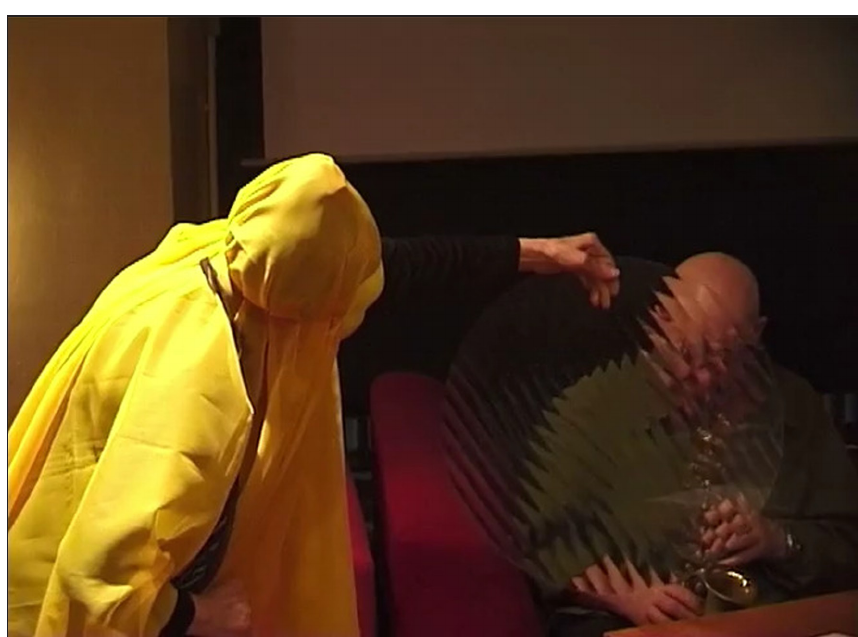
Figure 1.4: (25.53) Jennifer Pike and Lol Coxhill with Birdyak at the RCA, London 2002. Courtesy of William Cobbing, Maddie Coxhill and Ulrike